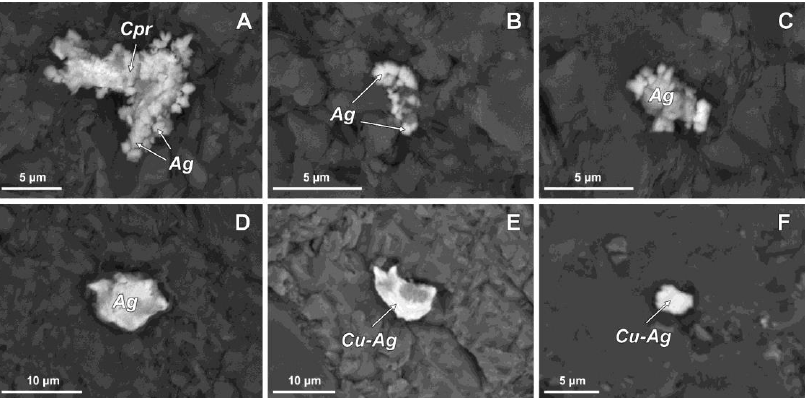
Figure 6. Rare earth element (REE)-bearing minerals in black shale from the Priorat DOQ region. ( A ) Euhedral xenotime (Xtm) crystal. ( B ) Elongated euhedral (La – Ce – Nd)-monazite (Mnz) crystal